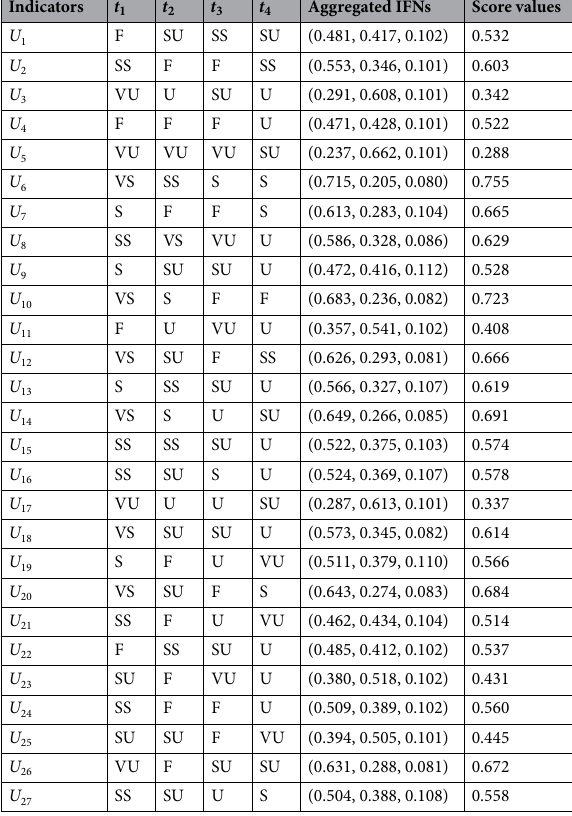
Table 9. Score values of